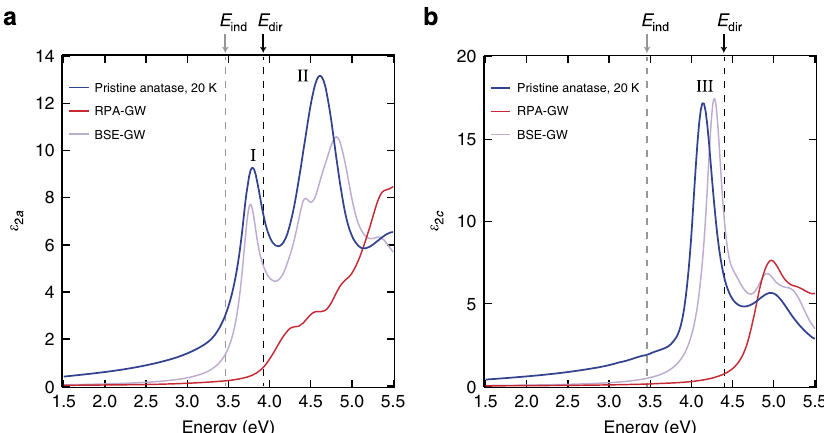
Fig. 6 Calculated optical spectra of pristine anatase TiO 2 . a , b Comparison between the spectra measured at 20 K on the pristine anatase TiO 2 single crystal and those obtained from frozen-lattice ab initio calculations for pristine anatase TiO 2 . The experimental data are reported in blue , the calculated spectra in the RPA-GW scheme in red and the calculated spectra in the BSE-GW scheme in violet . The quasiparticle indirect gap E ind = 3.46 eV is indicated by a dashed grey vertical line ; the direct gaps E dir = 3.92 eV (at the Γ point) for E ⊥ c and E dir = 4.40 eV (coincident with the onset of the RPA-GW) for E ǁ c are indicated by dashed black vertical lines in panel a and b ,